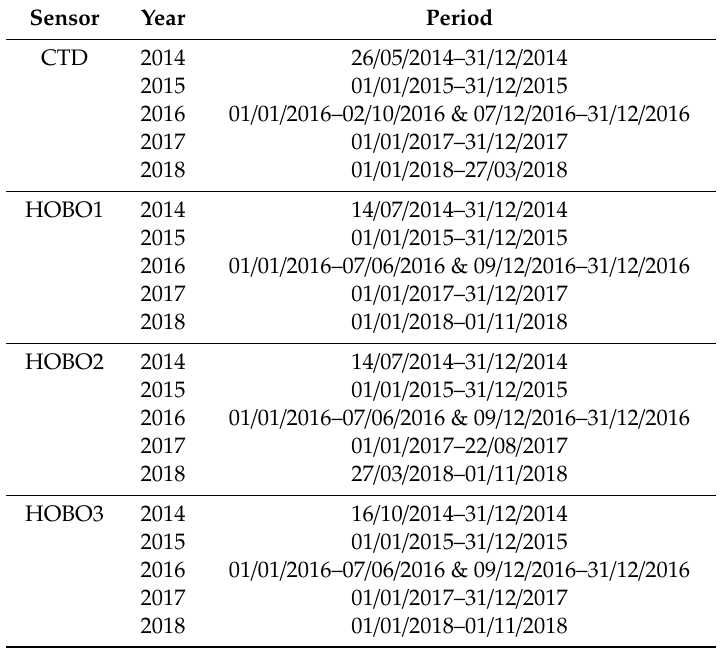
Table A1. Period of deployment for every sensor in the Underwater Biotechnological Park of Crete.